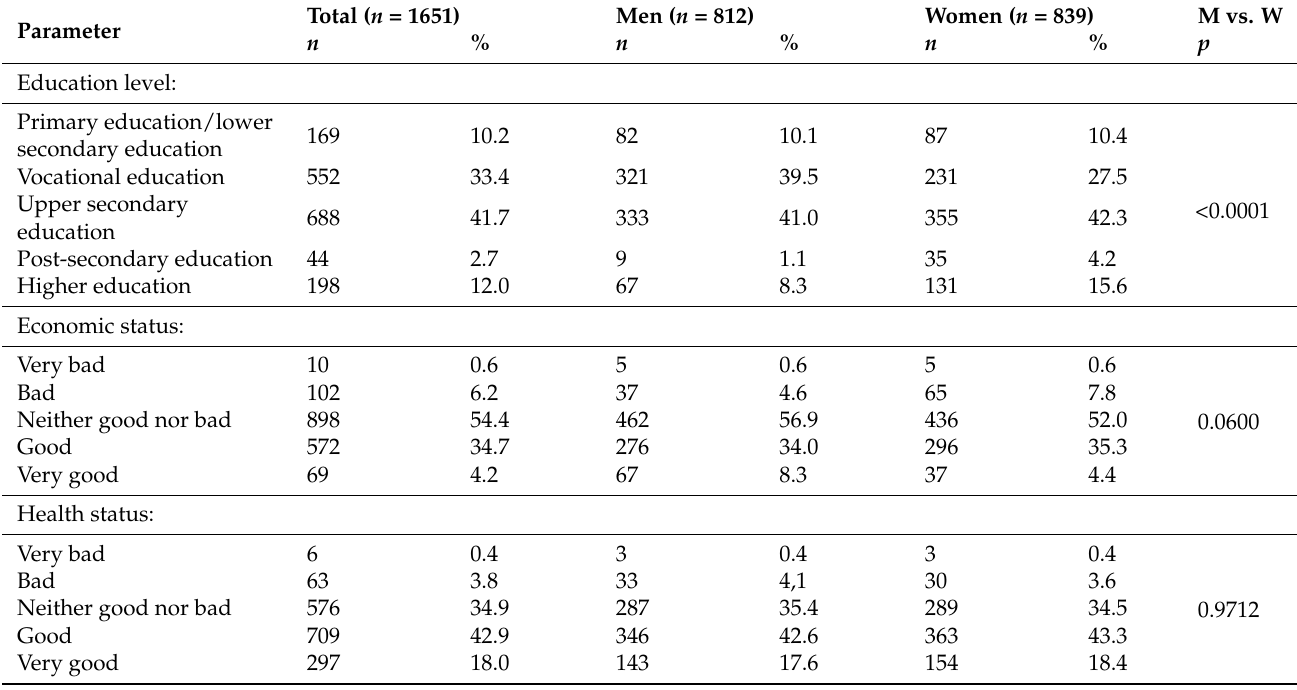
Table 2. Characteristic of